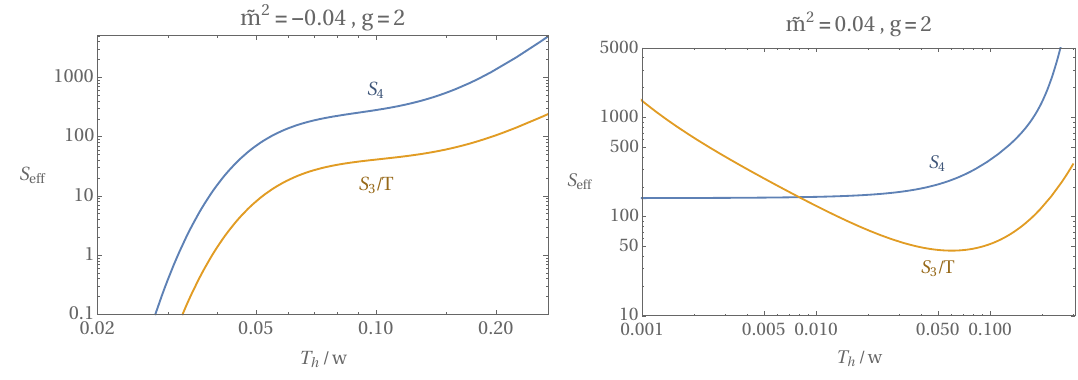
Figure 2 . Examples of the dependence of the critical bubble nucleation actions S 3 =T h and S 4 on the hidden sector temperature T h . The parameters g and ~ m 2 de(cid:12)ne the model via eq. (2.3). The left panel corresponds to a hidden sector for which the energy barrier between the two minima vanishes at zero temperature, so both S 3 =T h and S 4 go to zero. The right panel corresponds to a model in which a barrier remains at zero temperature, so S 4 asymptotes to a constant and S 3 =T h ! 1 .